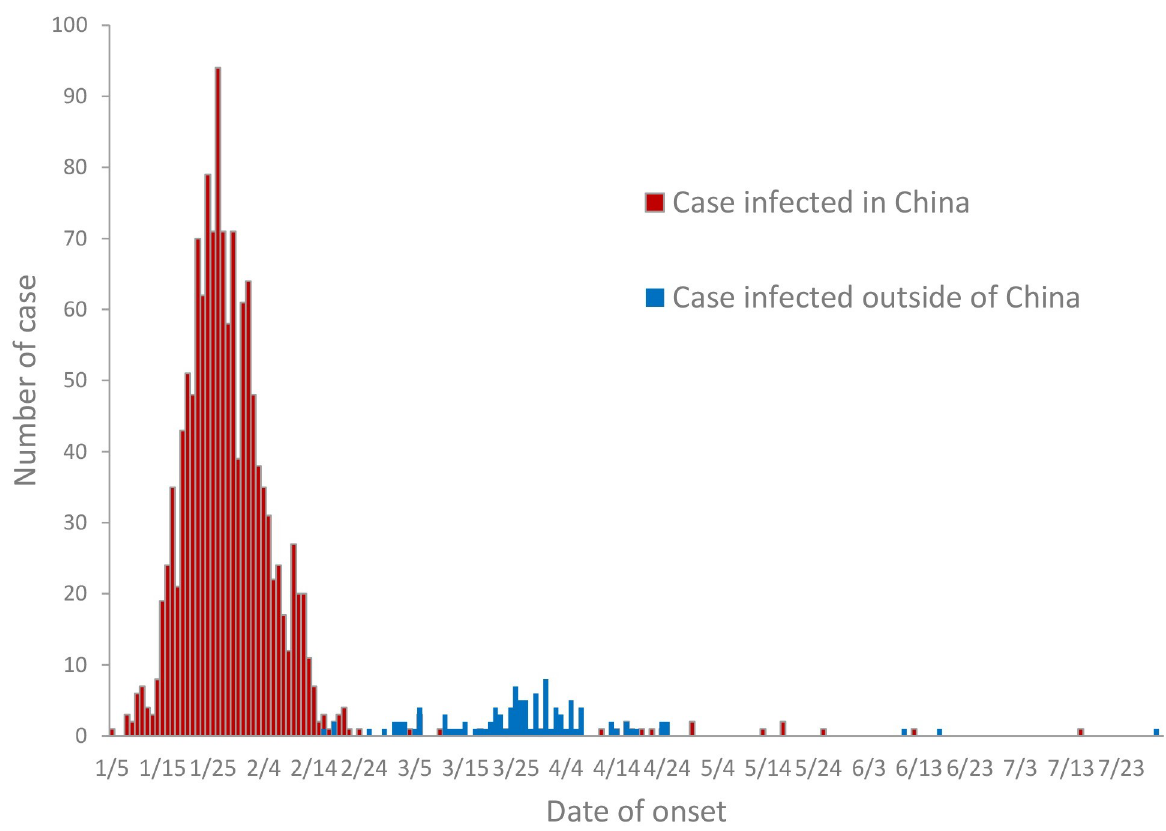
Fig 1. Onset of COVID-19 from January to July 2020 in Zhejiang Province,